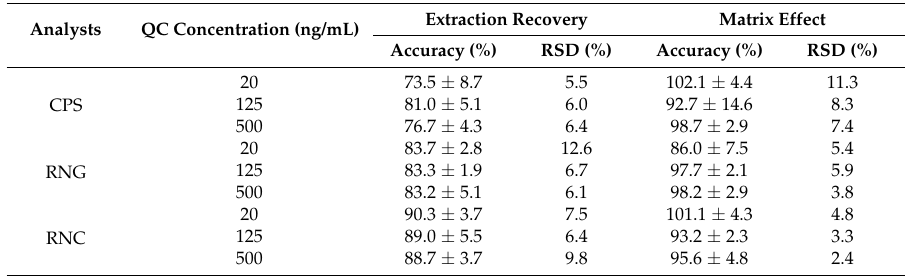
Table 3. The extraction recovery and matrix effect of CPS, RNG, and RNC in rat plasma ( n = 6). RSD:relative standard deviation.